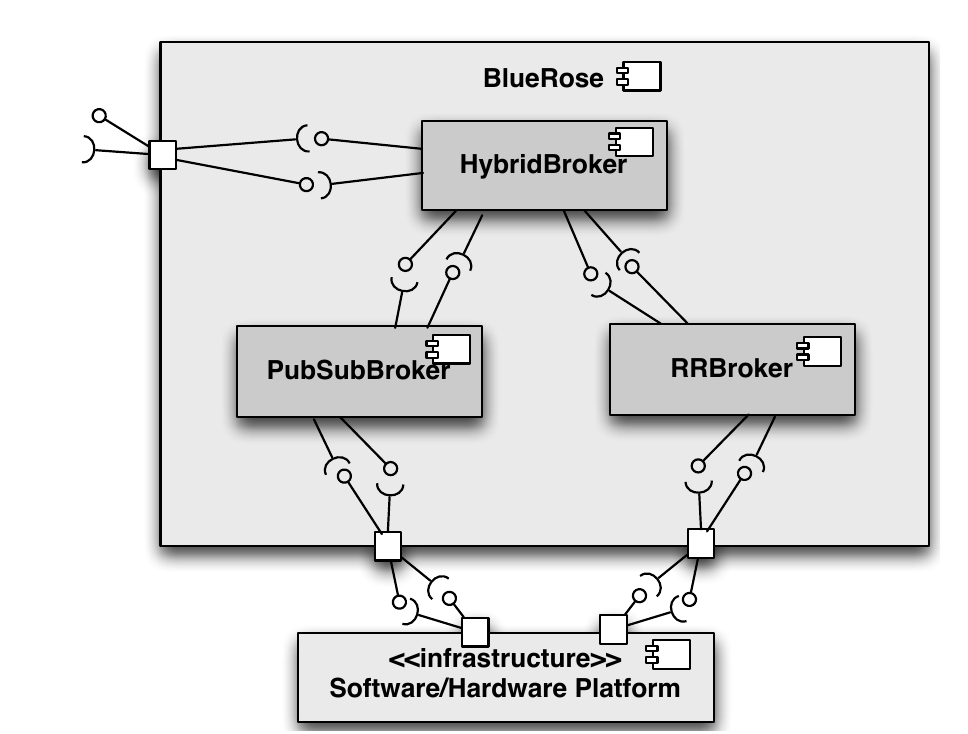
Figure 5. Simplified software architecture of